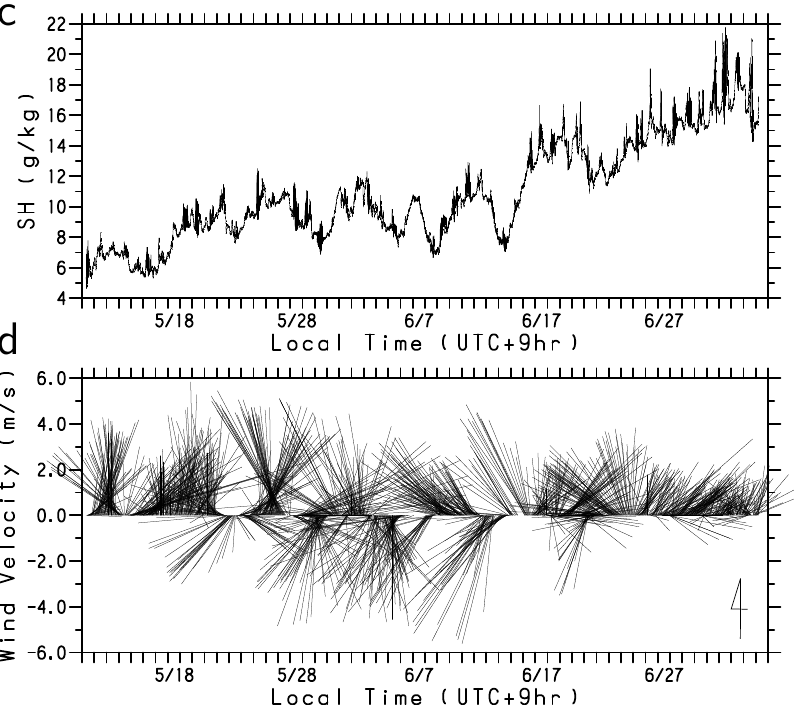
Figure 4. Time series of ( a ) SST ( ◦ C), ( b ) air temperature ( ◦ C), ( c ) specific humidity (gkg − 1 ), and ( d ) wind velocity vector (ms − 1 ). The abscissa is local time (UTC + 9h) during the observation period from 11 May to 5 July 2022.